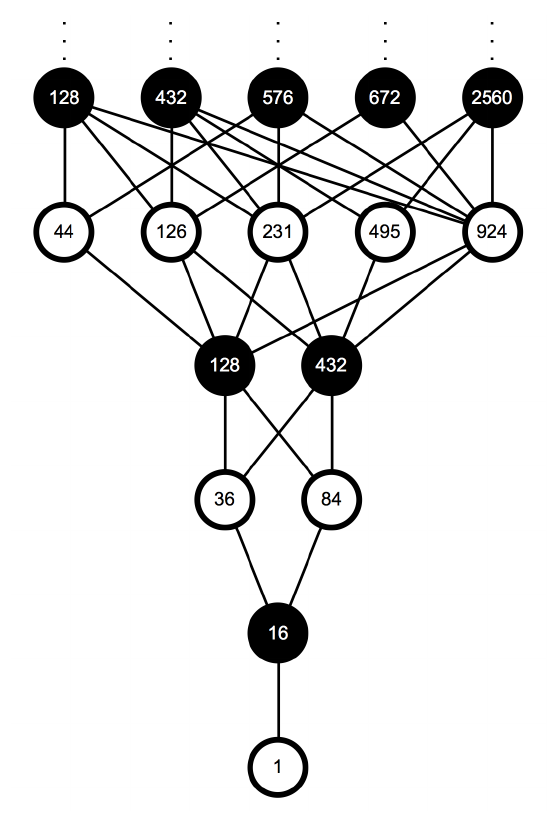
Figure 2 . Adinkra Diagram for 9D minimal scalar superfield.